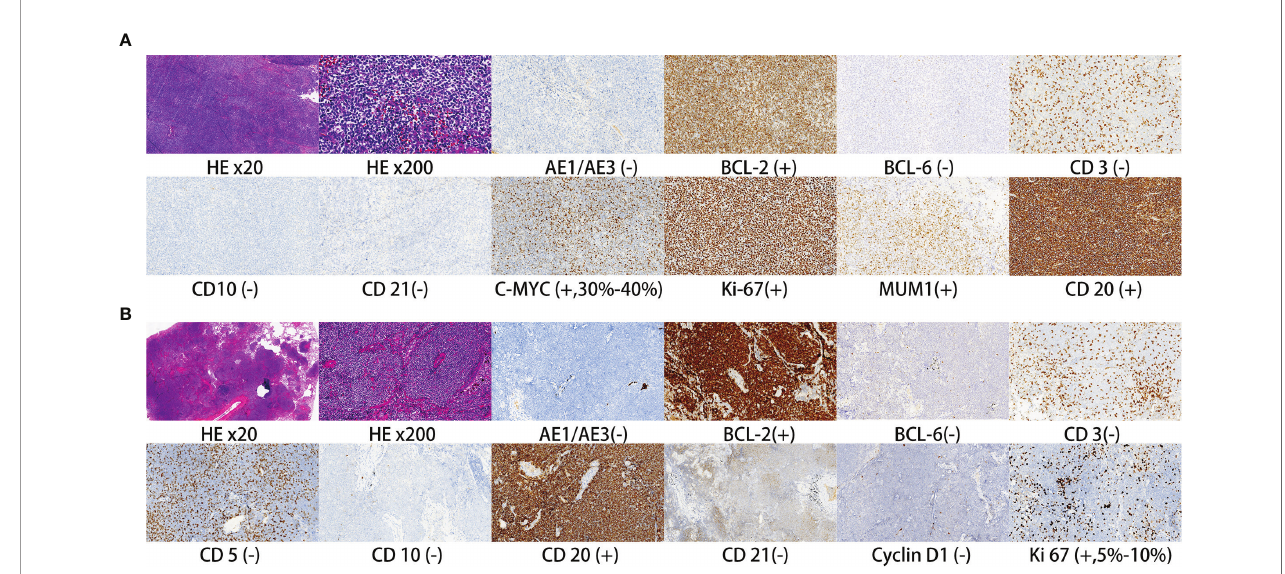
FIGURE 2 | Representative H&E and immunohistochemical staining of pulmonary DLBCL (A) and pulmonary MALT (B)